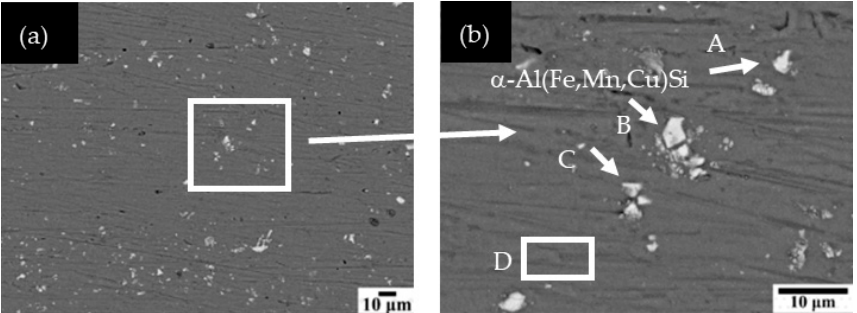
Figure 1. ( a ) SEM images ( × 500) of AA6061-T6 surface before immersion in Caribbean seawater and ( b ) zoom zone ( × 2000). Table 1. EDS analysis (wt.%) of reference aluminum alloy 6061-T6 surface.